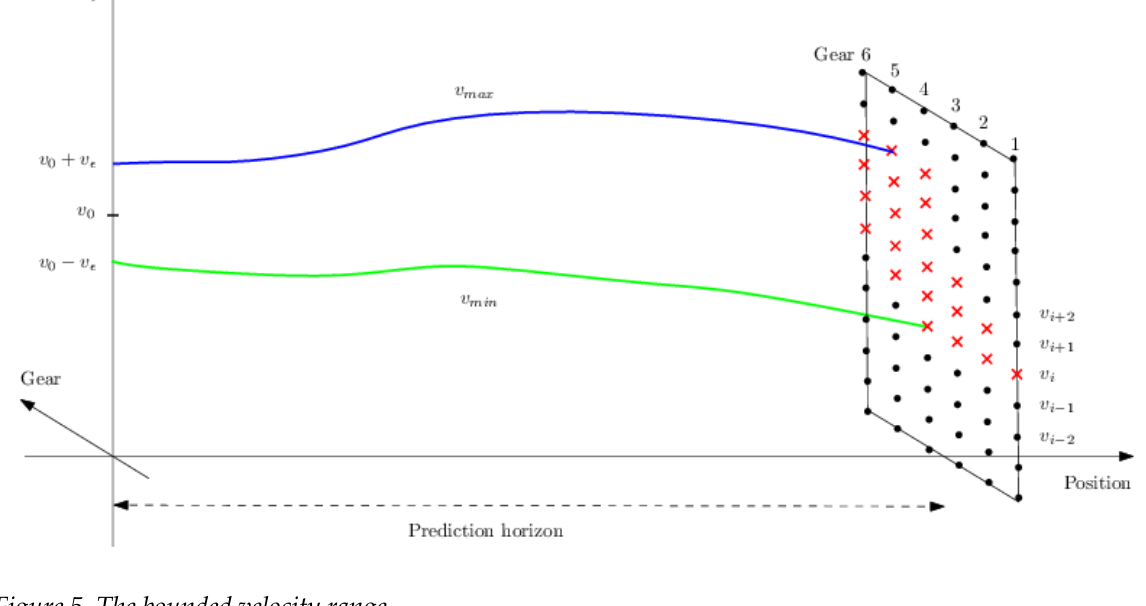
Figure 5. The bounded velocity